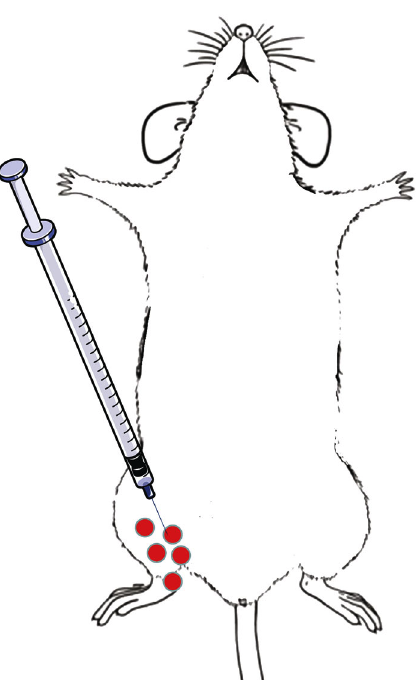
Figure 1: Diagram of PMSCs injection. PMSCs were injected at red